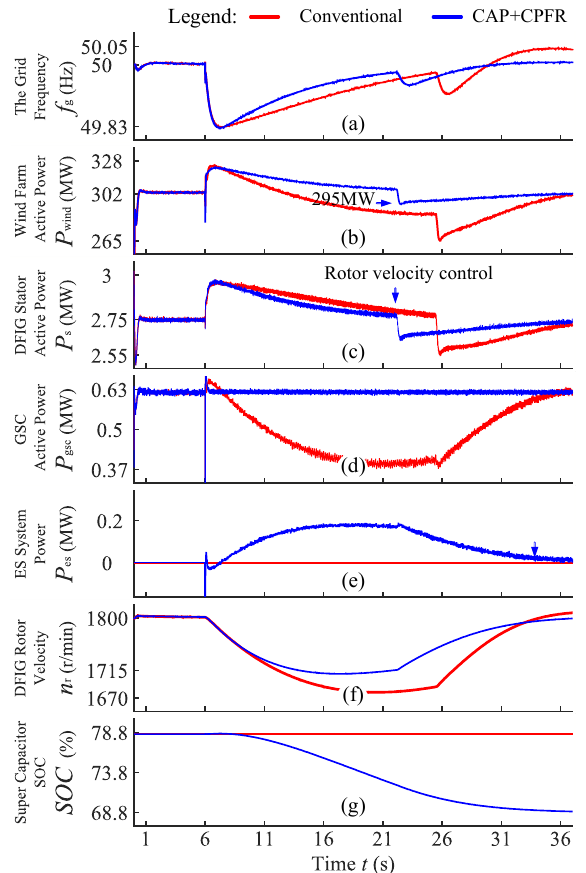
Figure 15. Frequency regulated operation waveforms of a wind farm at the rated wind speed: ( a ) The grid frequency; ( b ) The wind farm power; ( c – g ) The stator power, GSC power, generator unit power, ESS power, rotor velocity and ESS SOC of the DFIG-VSG system.